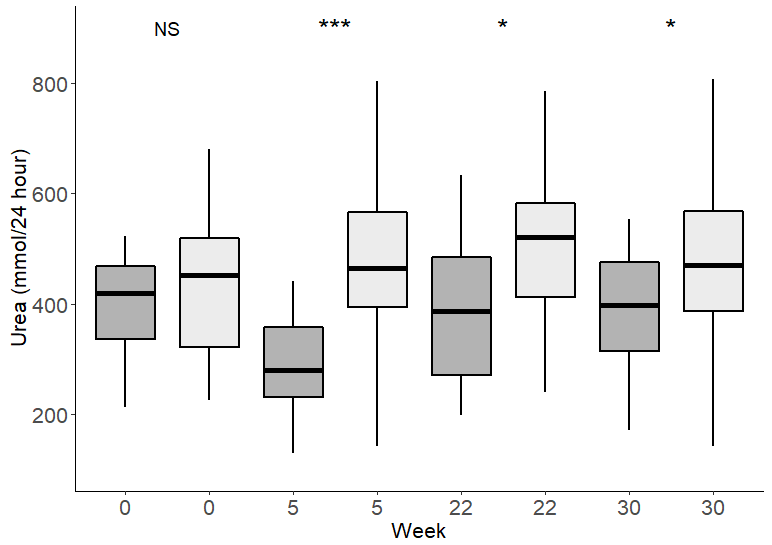
Figure 2. Twenty-four-hour UUN excretion. Dark boxes represent CD group and light boxes represent CRHP group. Before intervention start (week 0), during food provision (week 5), during and at end of follow-up (week 22 and 30). Between diet groups significance level; * p < 0.05, *** p < 0.001, NS = not significant.